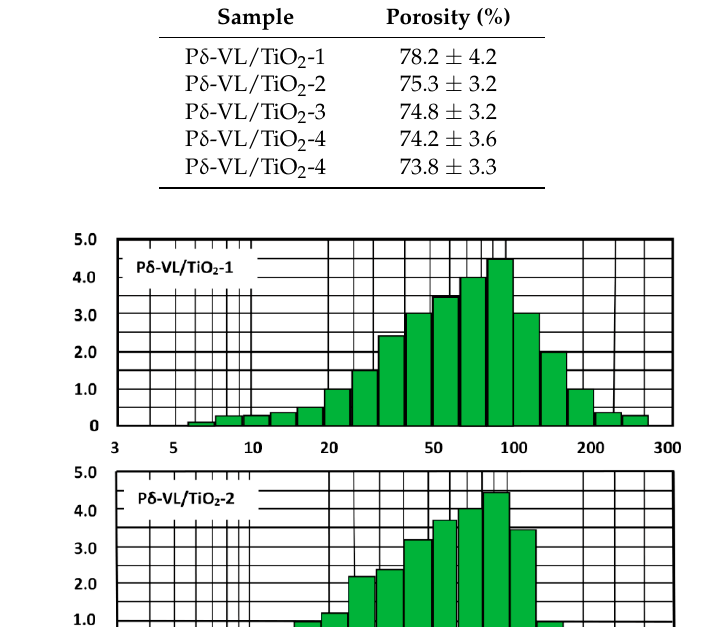
Table 3. The porosity of P δ -VL/TiO 2 hybrid materials containing different TiO 2 loads.